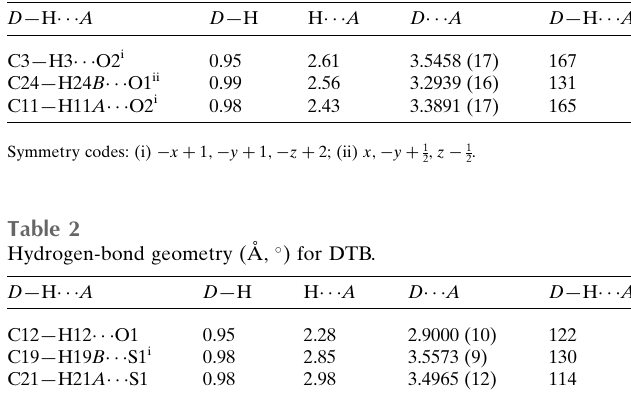
Table 1 Hydrogen-bond geometry (A˚ , (cid:3) ) for